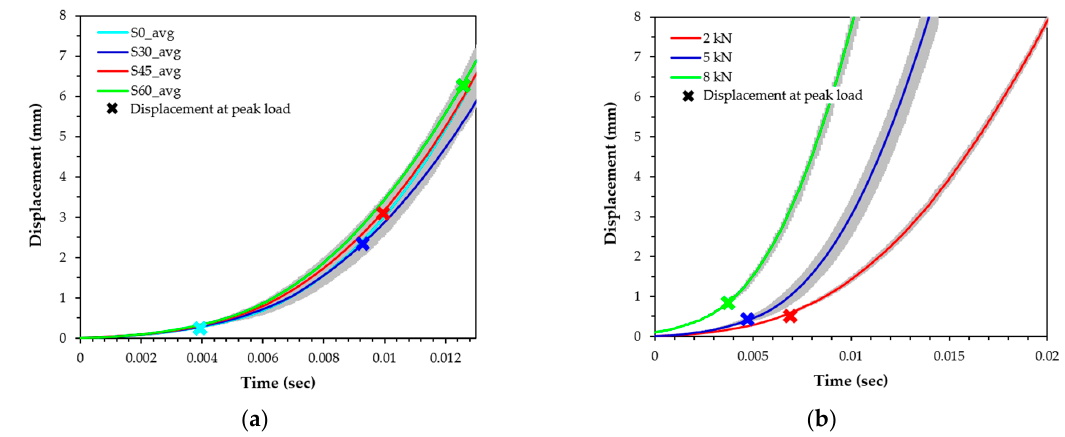
Figure 5. Time versus displacement curve: ( a ) displacement according to inclination angle at 5 kN, ( b ) displacement according to air pressure for aligned fiber.